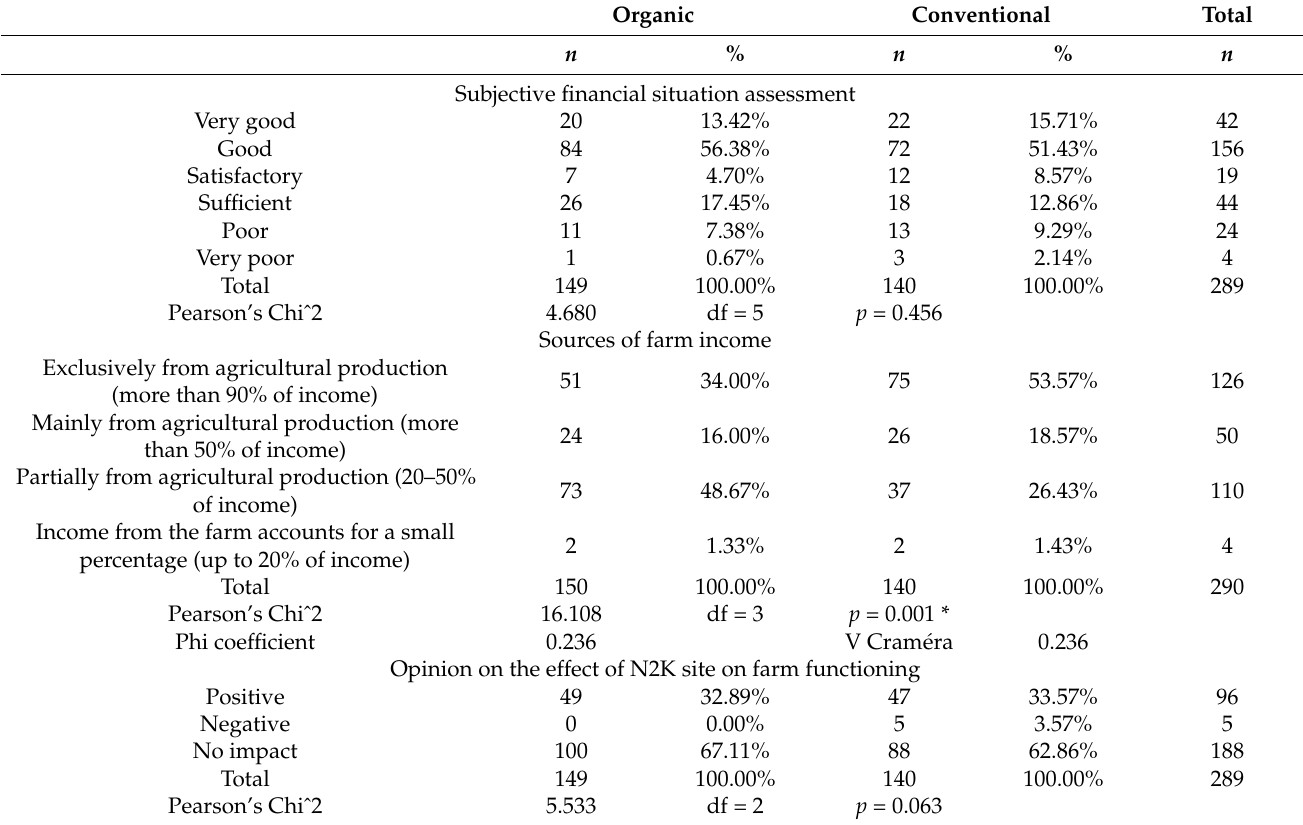
Table A3. Respondents’ opinions on their farm’s financial situation.